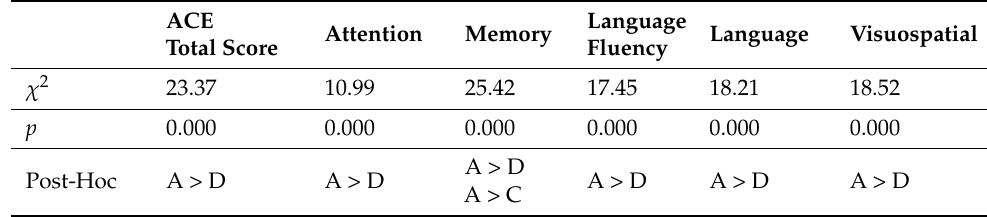
Table 3. Chi-square analysis of ACE score between four DEM types.